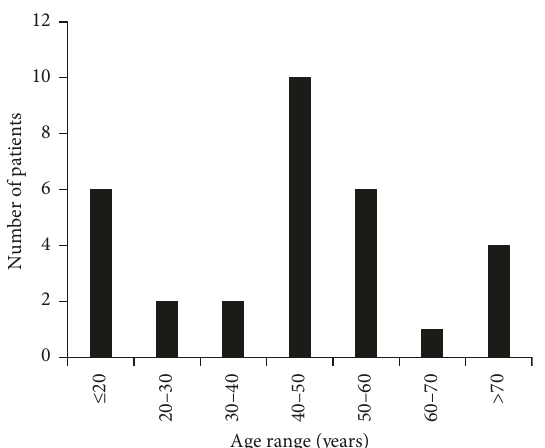
Figure 1: Age of patients with wound dehiscence.